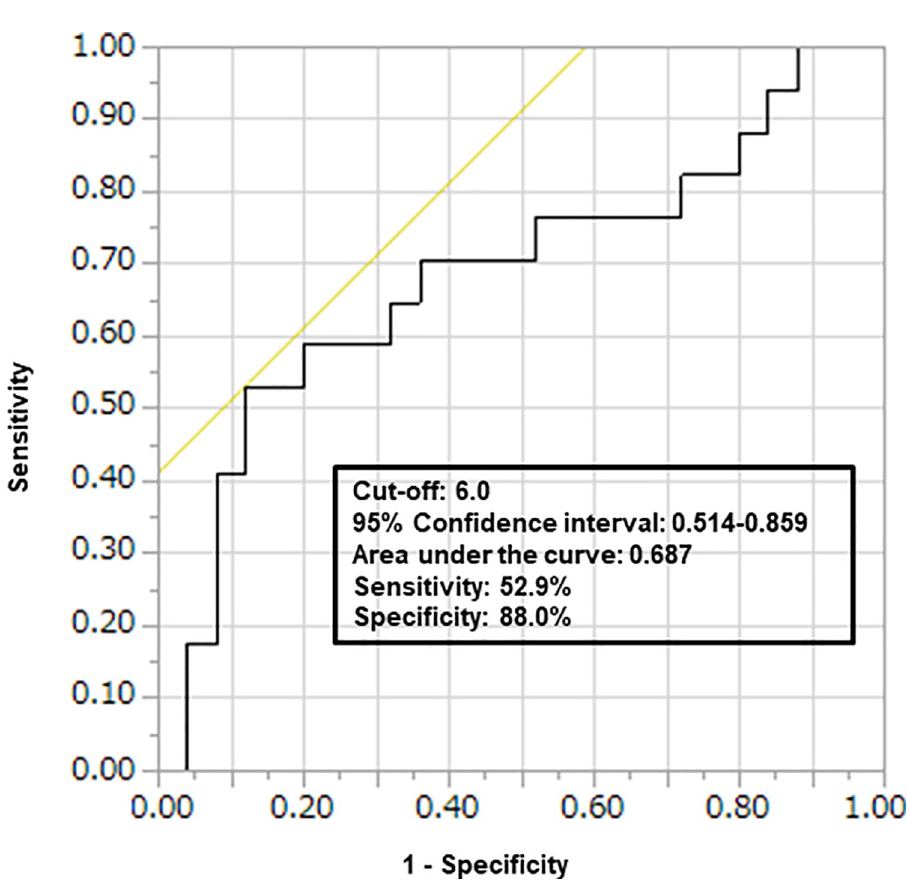
Fig 6. Receiver operating characteristic curve analysis of the Δ Muse versus the Δ volume.